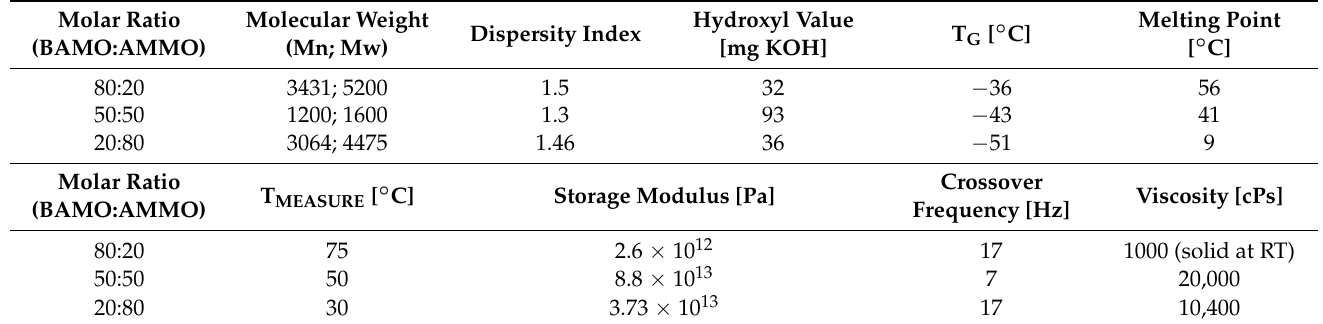
Table 1. Parameters detailing the composition of BAMO-AMMO copolymers reported in [30], as well as their fundamental thermal and mechanical properties.